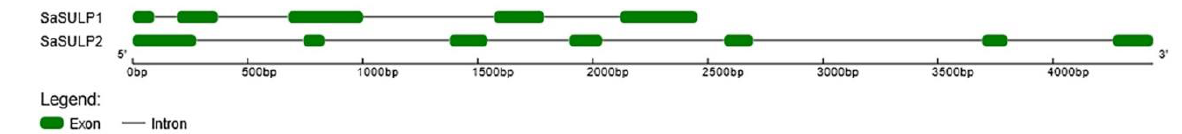
Figure 2. Structures of two SaSULPs genes.